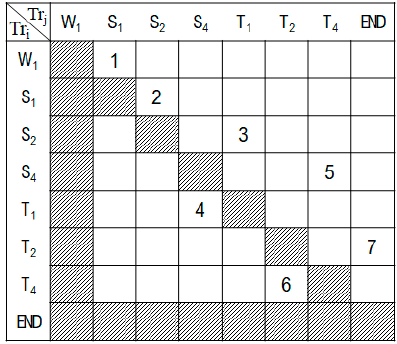
Figure 3. The values of gray and blank in the matrix are zero ( M ij = 0).